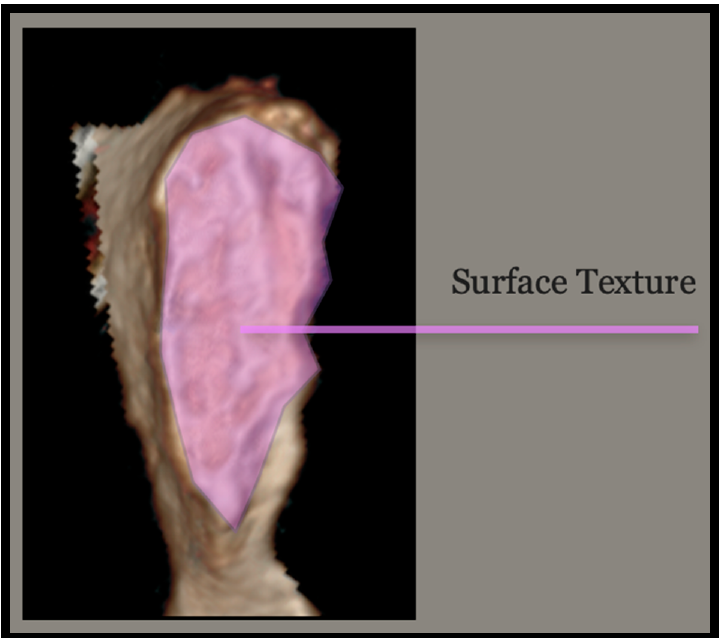
Figure 7. Guide to the Outline.